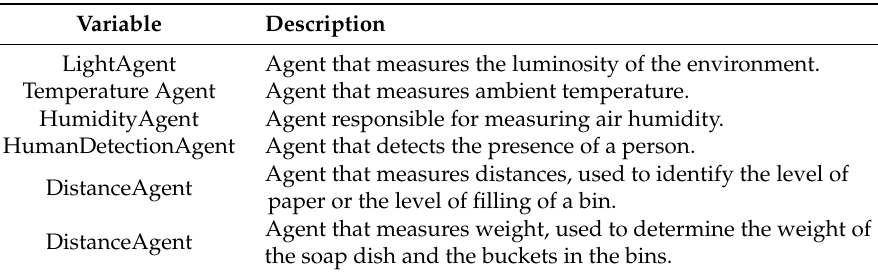
Table 1. Description of hardware